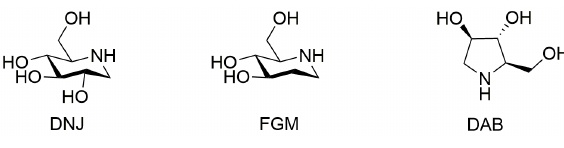
Figure 1. Chemical structures of DNJ, FGM, and DAB.